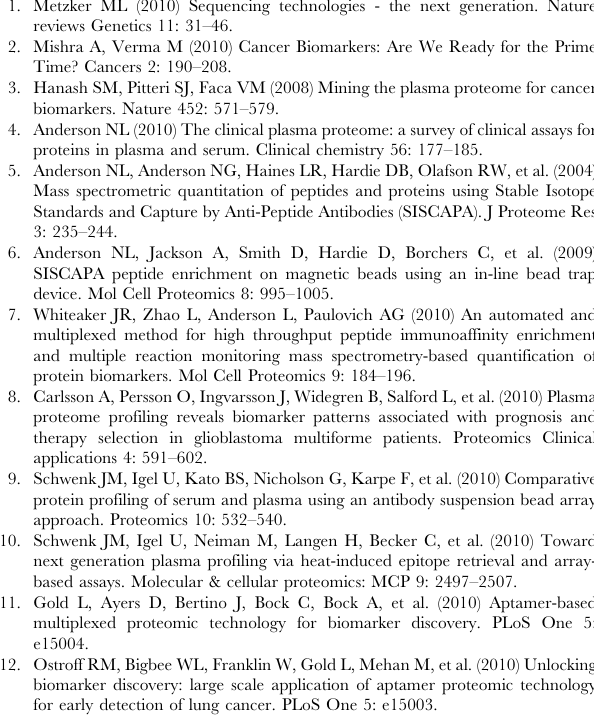
Table S4 List of antibodies used as PLA probes. Table S5 Sequences of PLA arms. Sequences of all oligonucleotides conjugated on antibodies by their 5 9 , which was modified by addition of a thiol group. Table S6 Sequences of PLA arms. Sequences of all oligonucleotides conjugated on antibodies by their 3 9 , which was modified by addition of a thiol group. Table S7 PCR primer sequences. Sequences of all PCR primers used in multiplex SP-PLA with qPCR readout. Table S8 Library preparation oligonucleotide sequenc- es. Sequences of all oligonucleotides used for the preparation of sequencing libraries. Table S9 Characteristics of patient and control